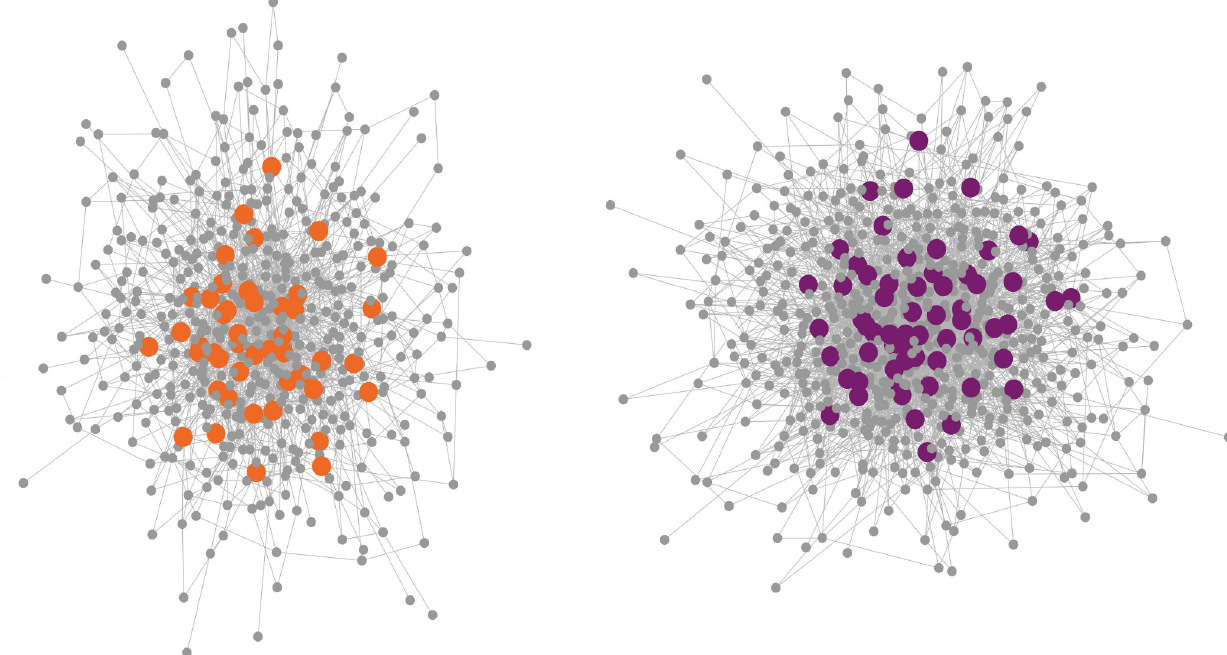
Fig 4. Visual representation of two network modules containing more than expected LFMM and PCAdapt outliers. Circles represent genes and lines show connections between them. Distance from the core signifies decreasing connectivity. Outliers, highlighted in color, are located in more central positions than expected by